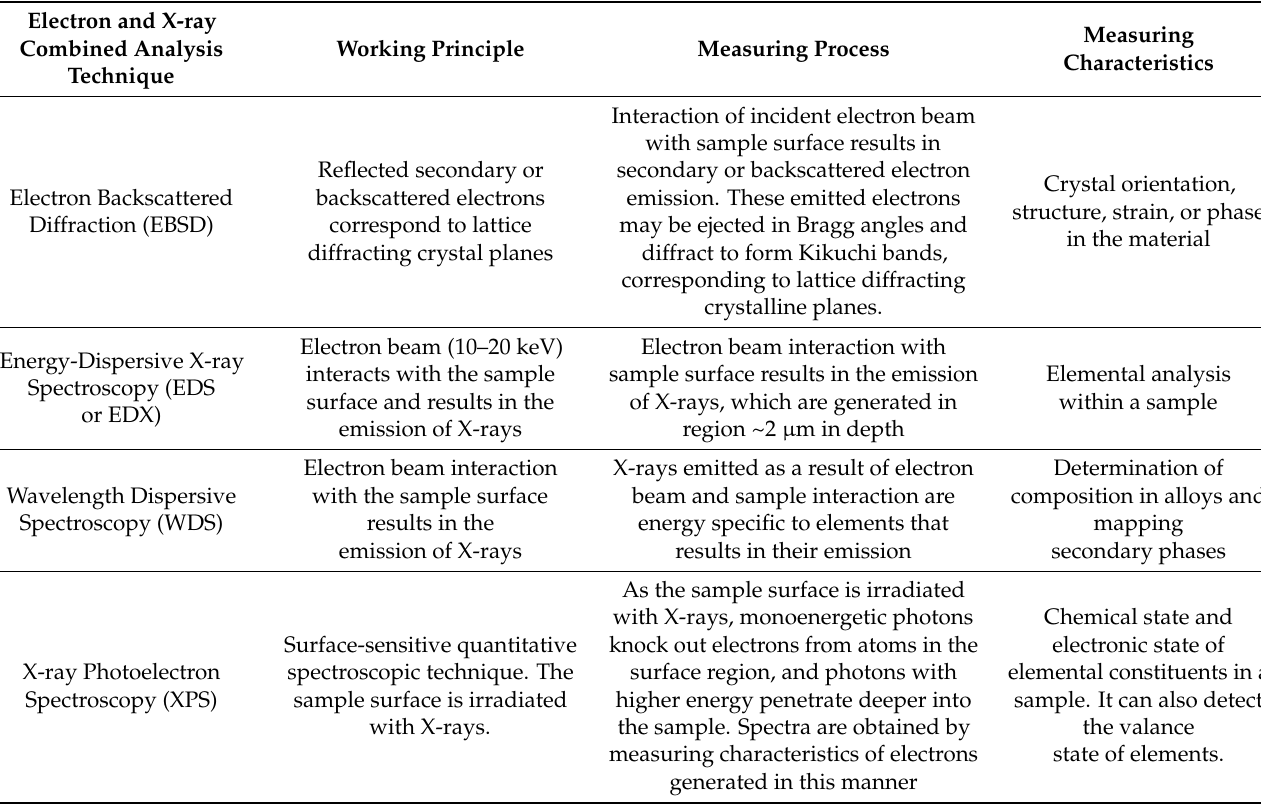
Table 6. Summary of electron and X-ray combined material characterization techniques